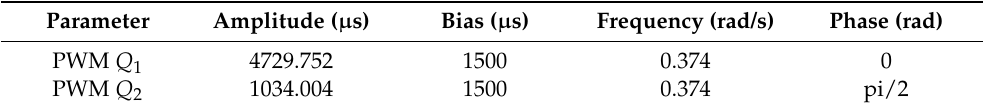
Figure 14. rpm to PWM conversion for angular position. The final PWM curves obtained had an approximate sine waveform with the parame- ters in Table 6. Table 6. PWM sine wave signal